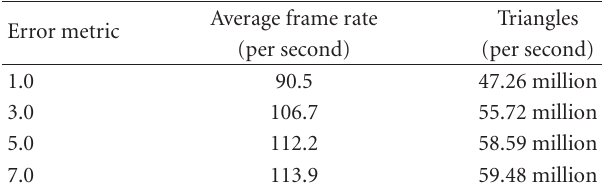
Table 1: Frame rates for specific error